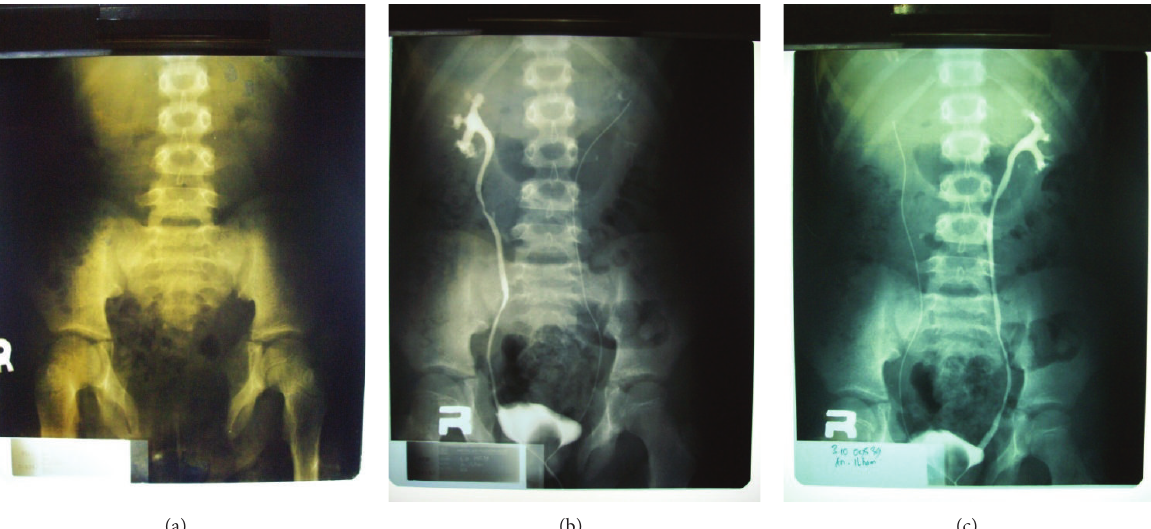
Figure 3: Plain photo showed pubic symphysis diastasis (a); retrograde pyelography showed normal ureter and no ureterovesical reflux (b) and